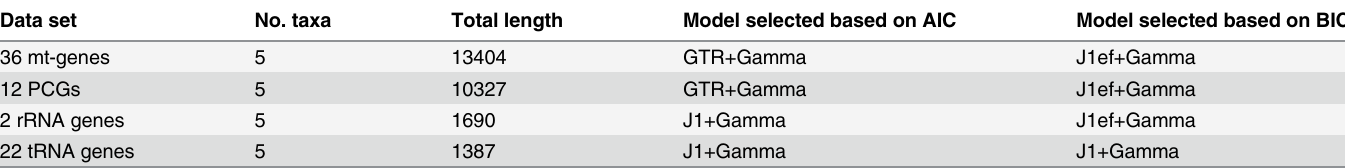
Table 1. Information of the aligned sequences of 36 mitochondrial genes, 12 protein-coding genes (PCGs), 2 rRNA and 12 tRNA genes of Angios- trongylus costaricensis and related taxa. AIC, Akaike Information Criterion; BIC, Bayesian Information Criterion. Data